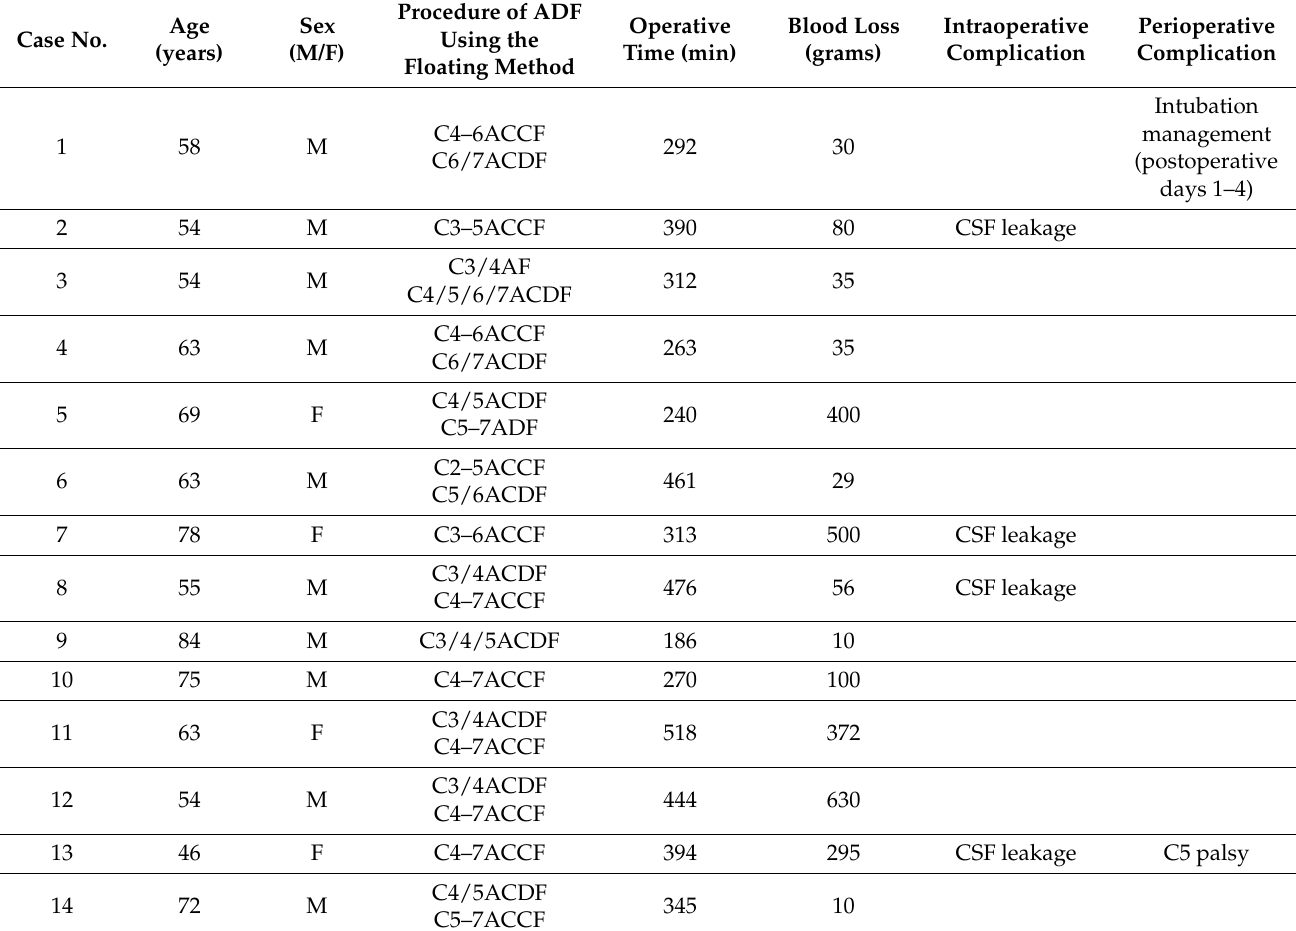
Table 1. Patient characteristics and surgical procedure